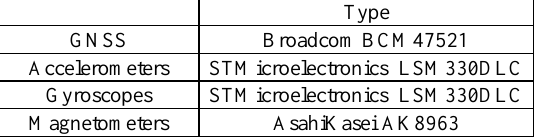
Table 1. GPS and motion sensors in Samsung Galaxy S4